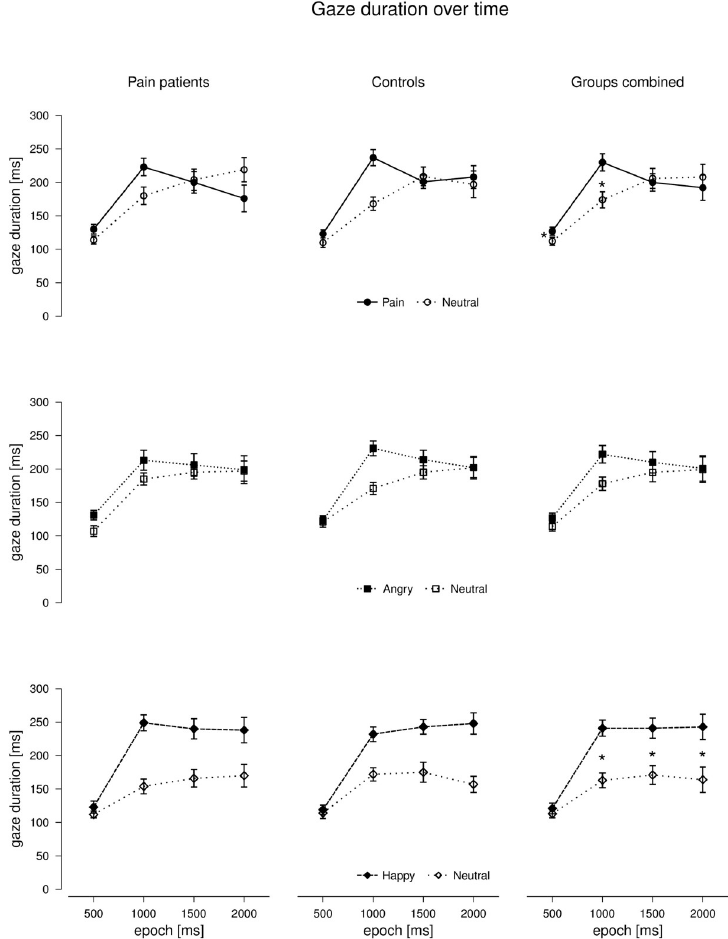
Fig 2. Means ( ± SE) of the absolute fixation durations for the three emotional stimulus classes (pain, angry and happy faces) compared to neutral faces over 4 epochs of 500 ms during stimulus presentation separately for pain patients and controls and for both groups combined. Asterisks indicate significant differences.